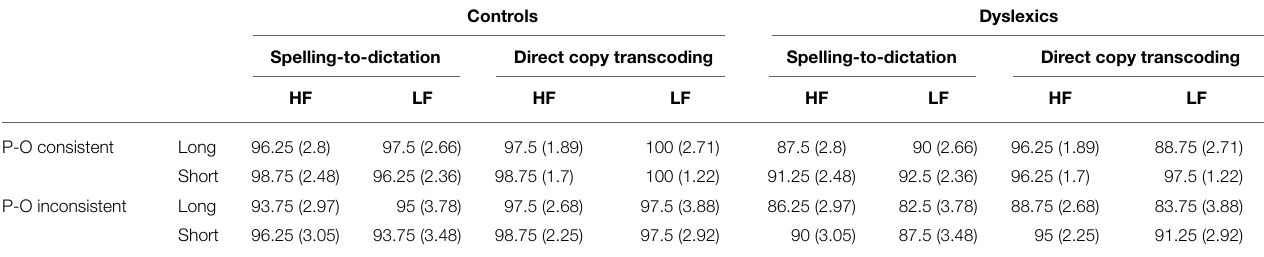
TABLE 4 | Mean percentage of correct responses and standard deviations (in parentheses) for each condition in the control and the dyslexic group. Controls Dyslexics Spelling-to-dictation Direct copy